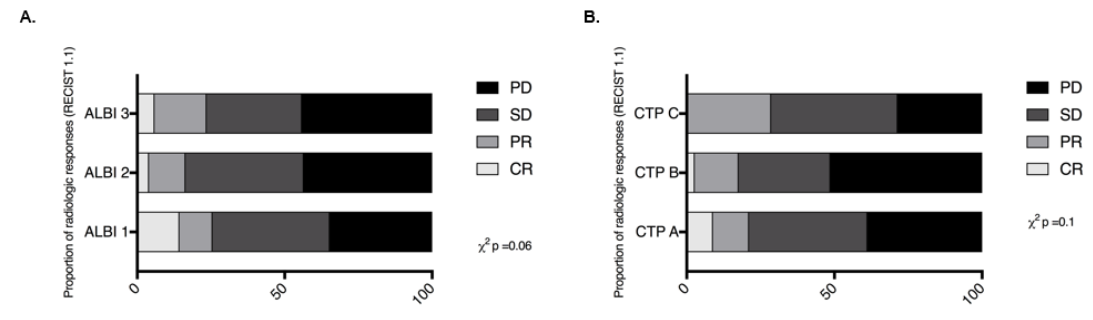
Figure 2. The relationship between ALBI grade ( A ) and Child-Turcotte-Pugh (CTP) class ( B ) and radiologic disease control by RECIST 1.1 criteria in patients with hepatocellular carcinoma (HCC) treated with immune checkpoint inhibitors (ICI).